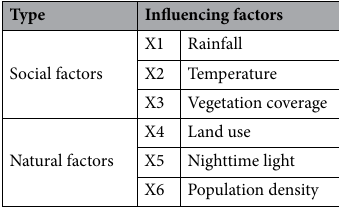
Table 6. Influencing factors.